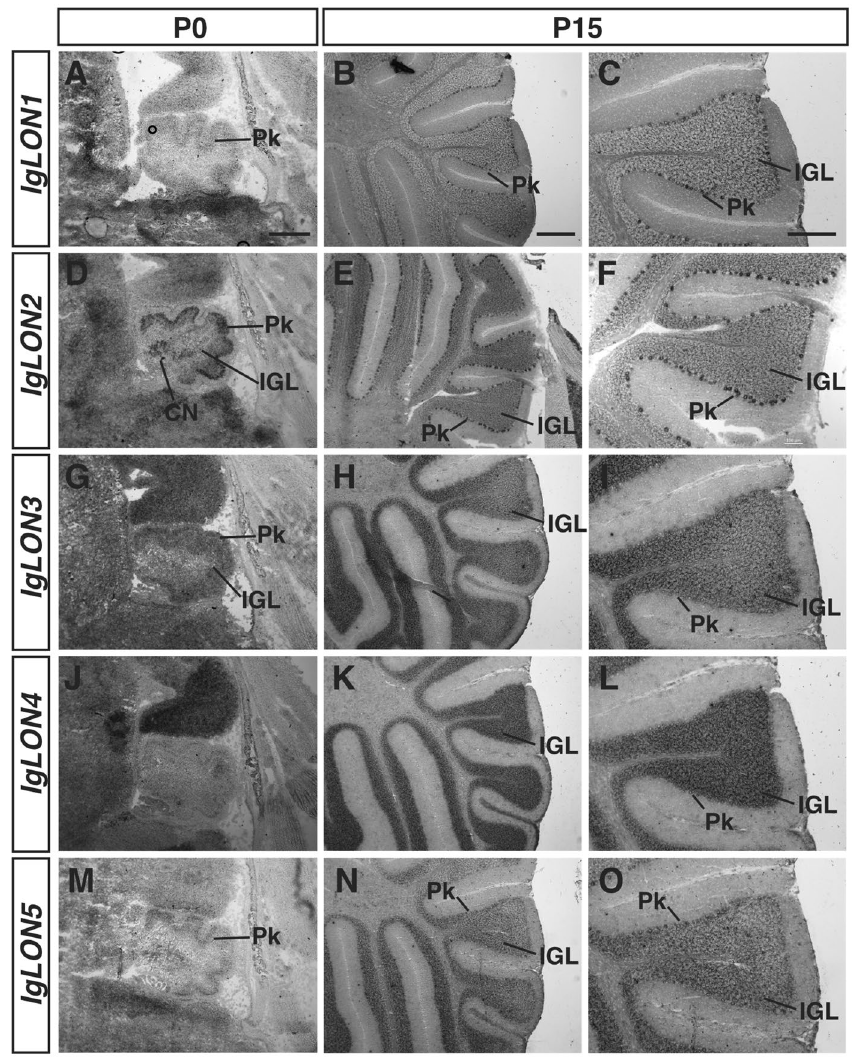
Figure 7. IgLONs mRNA expression in the cerebellum. In situ hybridization of sagittal sections from P0 and P15 mouse brains with antisense cRNA probes for IgLON transcripts. IgLON1 was expressed at low levels in the Purkinje cell layer (Pk) at P0 and P15 ( A – C ). IgLON2 showed expression in the Pk and in the internal granule layer (IGL) at P0 and P15 ( D – F ). IgLON3 mRNA could be detected in the IGL and at low levels in the Pk at P0 and P15 ( G – I ). IgLON4 showed weak expression in the Pk at P0 ( J ) but was restricted to the IGL by P15 ( K , L ). IgLON5 mRNA expression was detected in the Pk layer at P0 and in both Pk and IGL layers at P15 ( M – O ). Scale bars = 200 µm ( A , C , D , F , G , I , J , L , M , O ) and 500 µm ( B , E , H , K , N